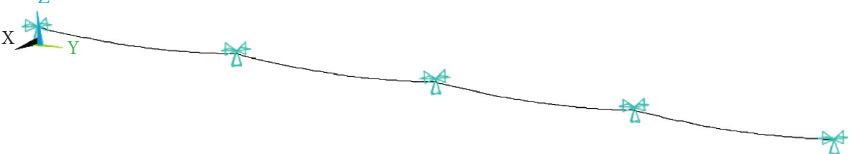
Figure 5: Isometric view of the FEM with four-span conductors in ANSYS software.